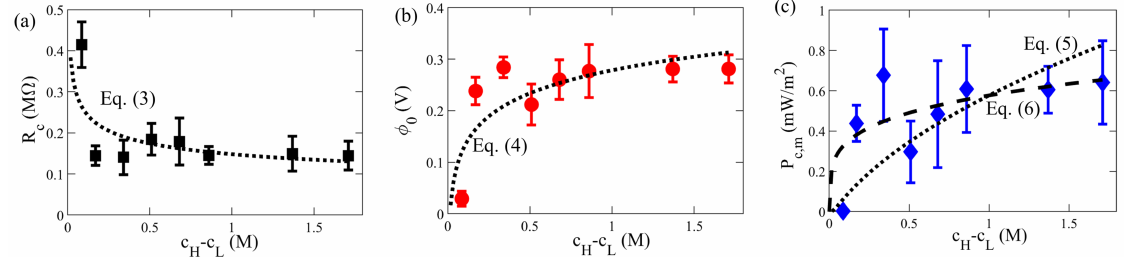
Figure 5. Variation of ( a ) internal resistance, R c , ( b ) open-circuit voltage, φ 0 , and ( c ) maximum power output density, P c , m , at q f = 1000 µL/min for various concentration difference, ∆ c ( = c H − c L ). The dotted lines in ( a – c ) represent Equations (4) and (5), respectively. The dashed line in ( c ) demonstrates the curve-fit using the simplified relation